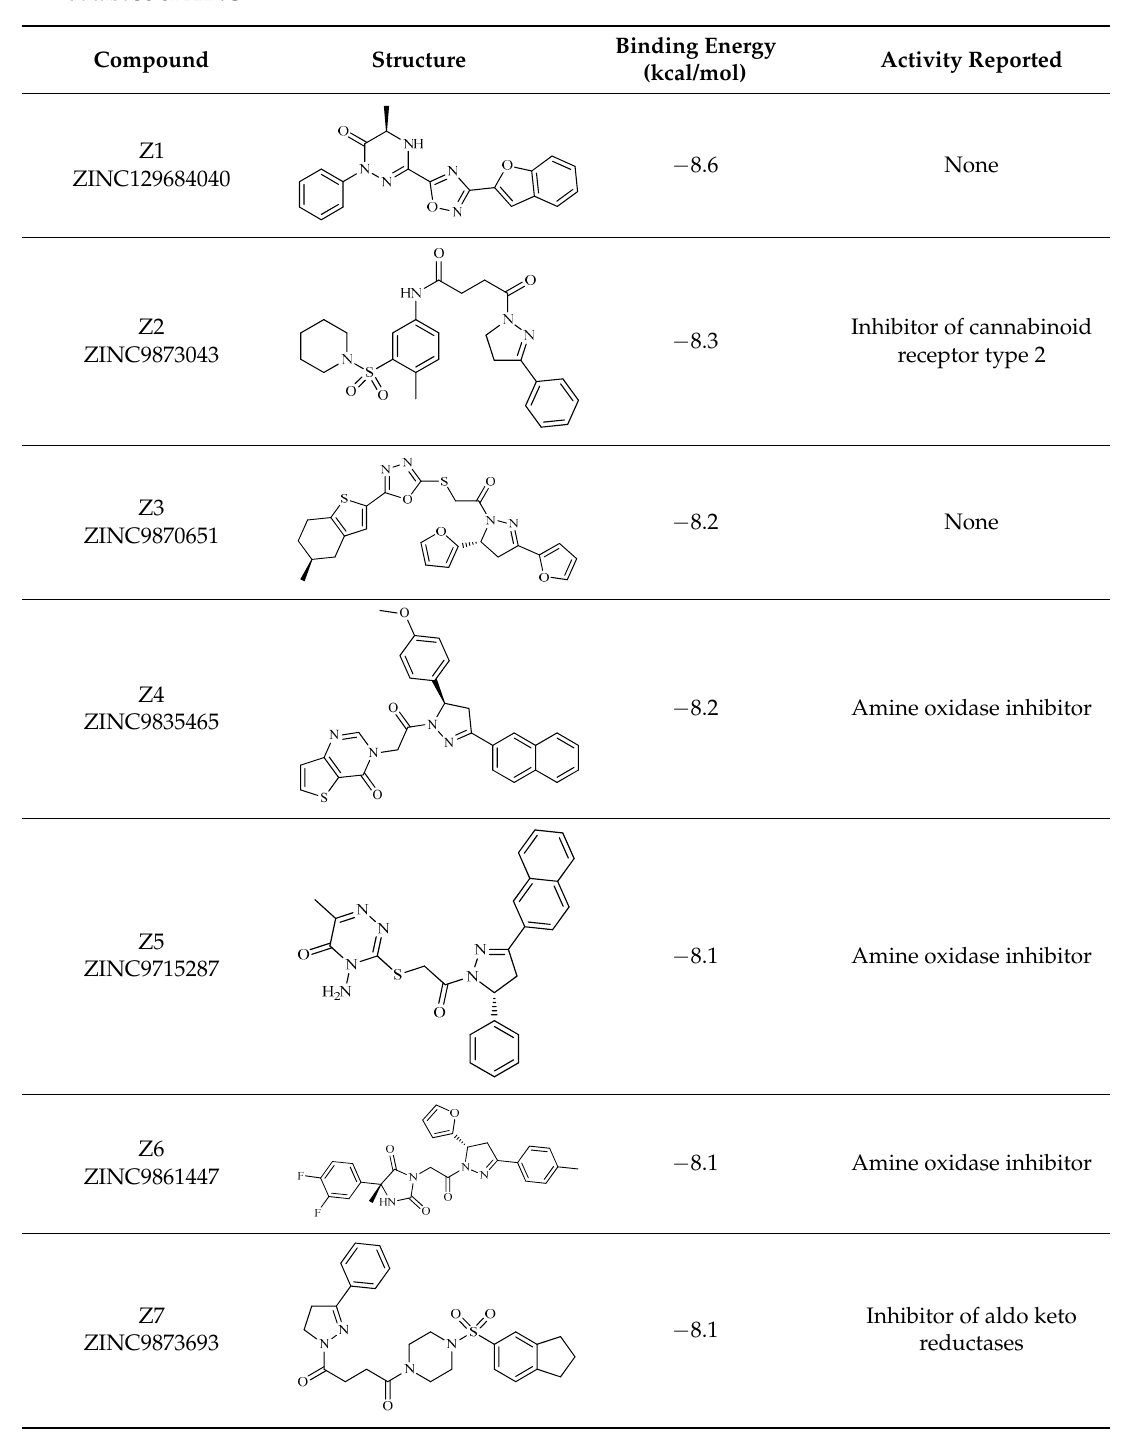
Table 1. Structures of the top ten compounds with the best binding energies obtained from a clean lead database of ZINC 15 .